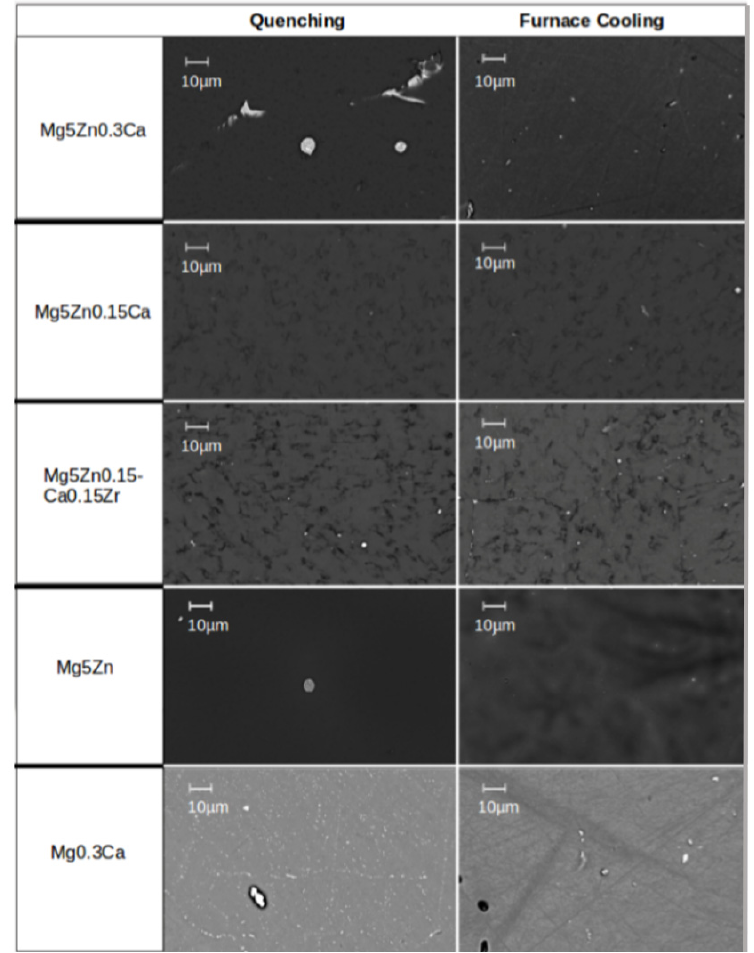
Figure 5. SEM image of the as ‐ cast alloy Mg5Zn0.3Ca, ( a ) with about 100× magnification ( b ) with about 500× magnification.